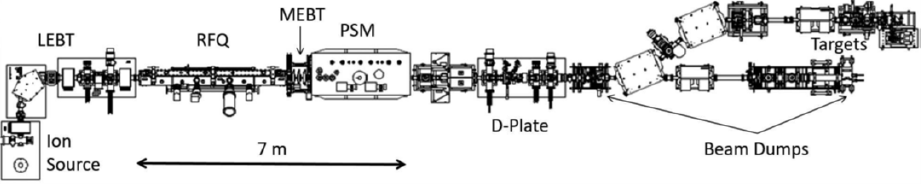
Figure 1: Layout of SARAF Phase I; see text for